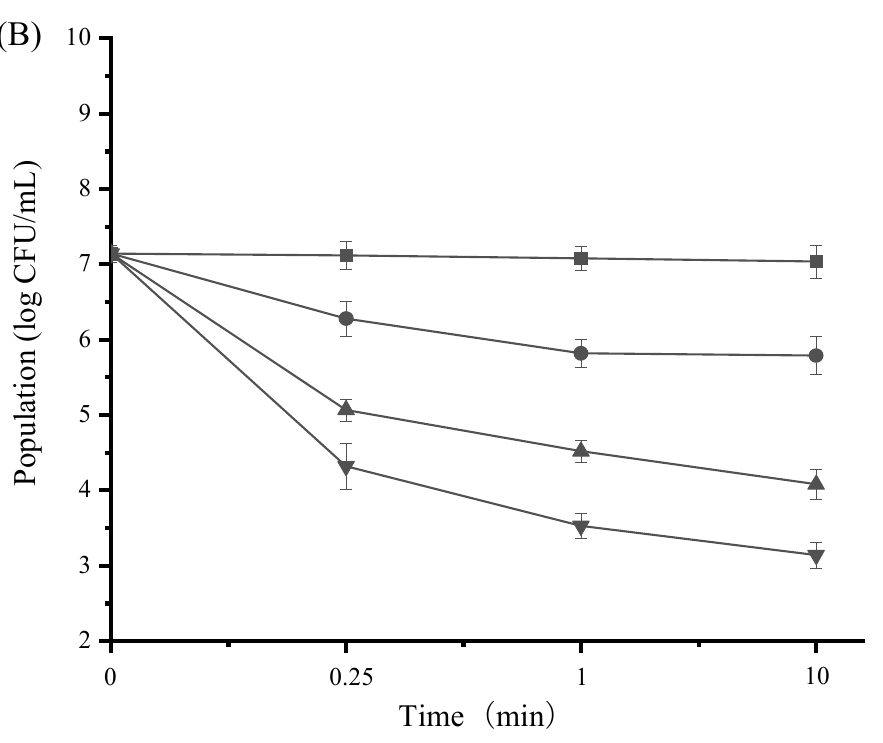
Figure 4. Inhibitory effect of hand sanitizers containing SAMs against E. coli ( A ) and S. aureus ( B ) during incubation at 37 °C for 10 min. The following concentrations of SAMs were used: control ( ■ ), 1/2 × MIC ( ● ), 1 × MIC ( ▲ ), and 2 × MIC ( ▼ ). Values are displayed as the mean ± standard deviation.